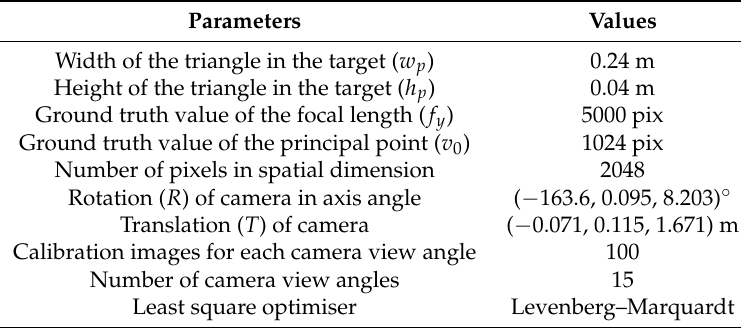
Figure 6. Simulation of a line-scan camera facing a calibration target. The line-scan camera is represented by the blue, red, and green axes, which represent X , Y , and Z -axes of the line-scan camera, respectively. The camera view plane is represented by red dash lines. Contours of triangles in the calibration target are represented by black lines. The intersection points of the camera view plane and contours of black triangles are denoted by blue dots. The X , Y , and Z -axes of the figure represent the coordinate frame of the target. Table 1. Parameters in